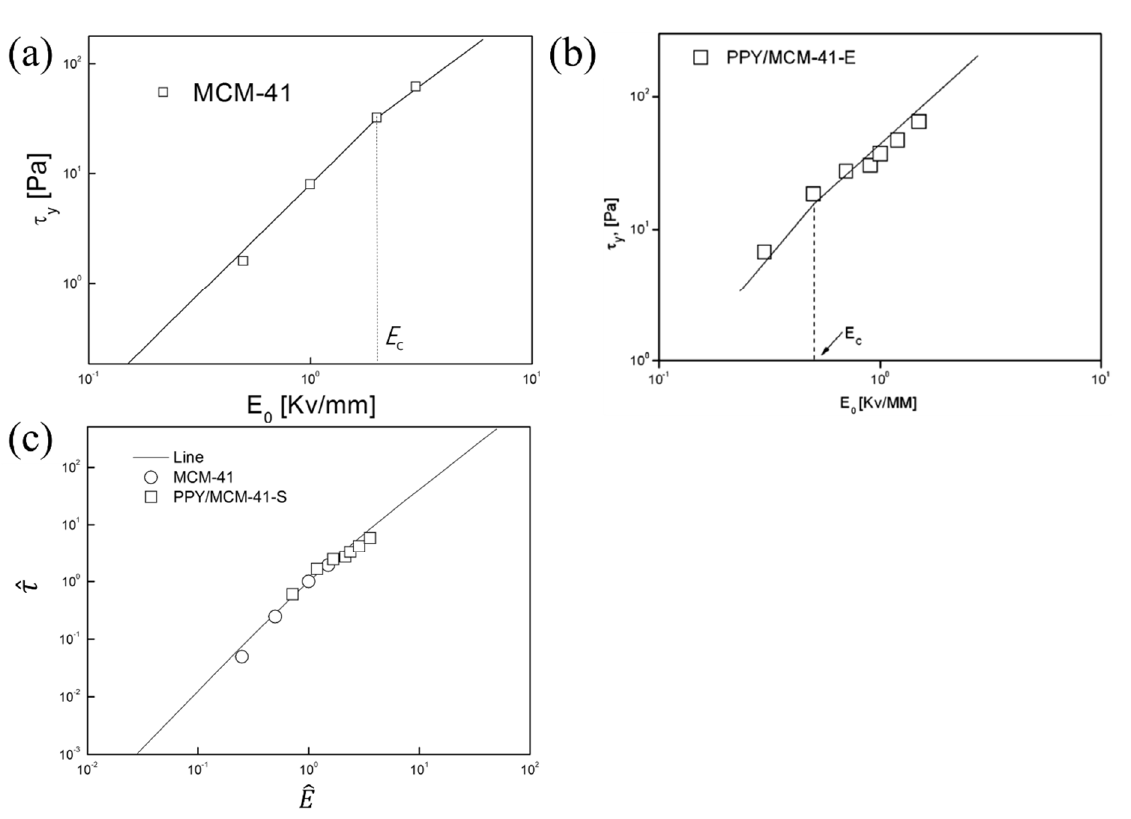
Figure 7. ( a ) Dynamic yield stress of MCM-41-based ER fluids at four different electric field strengths; ( b ) Dynamic yield stress of PPy/MCM-41-based ER fluids at seven different electric field strengths (Reproduced with permission from [59]. Copyright Elsevier, 2010); ( c ) τ(cid:3548) vs. (cid:1831)(cid:3552) for pure MCM-41 and PPy/MCM-41-based ER fluids. The solid line is drawn with Equation